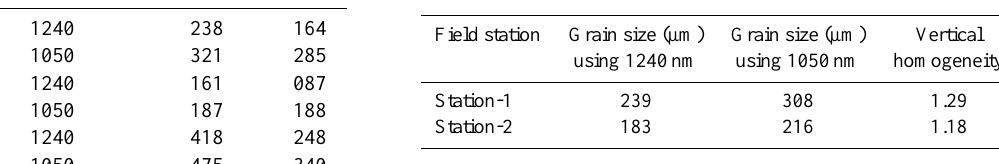
Table 3. Retrieved snow grain size in different study areas of west- ern Himalaya, where SD is standard deviation. Study area NIR wavelength